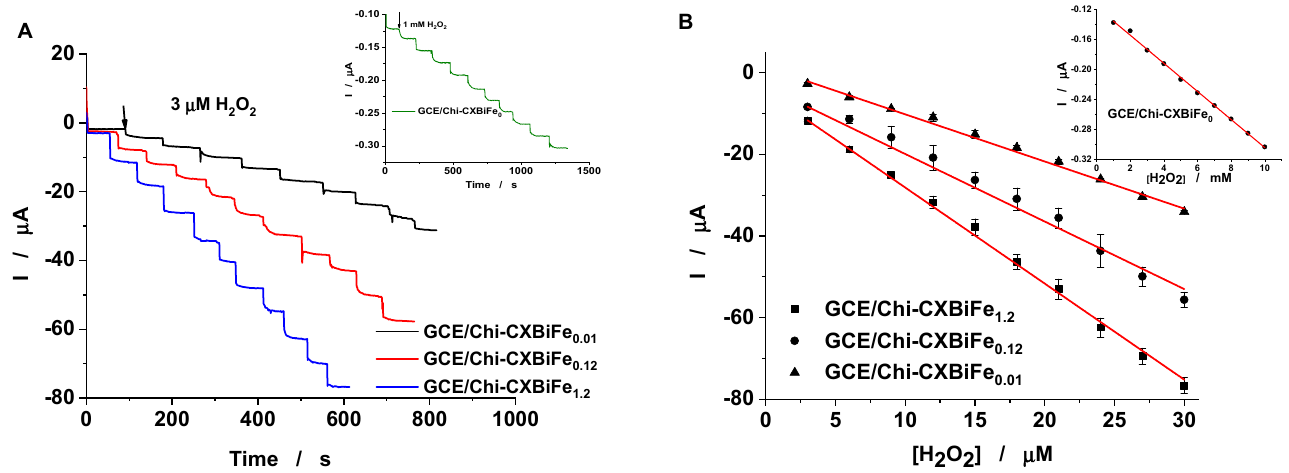
Figure 6. I vs. time dependence recorded at GC/Chi–CXBiFe x , for successive addition of 3 µ M H 2 O 2 , and 1 mM H 2 O 2 , respectively ( A ), and the corresponding amperometric calibration curve ( B ). Experimental conditions: rotating speed 400 rpm; supporting electrolyte, 0.2 phosphate buffer M (pH 7); applied potential, − 0.3 V vs. Ag/AgCl, KCl sat.